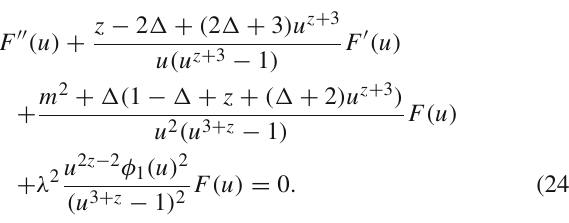
(blue) in the left panel, while the conductivity for fixed γ = − 6 100